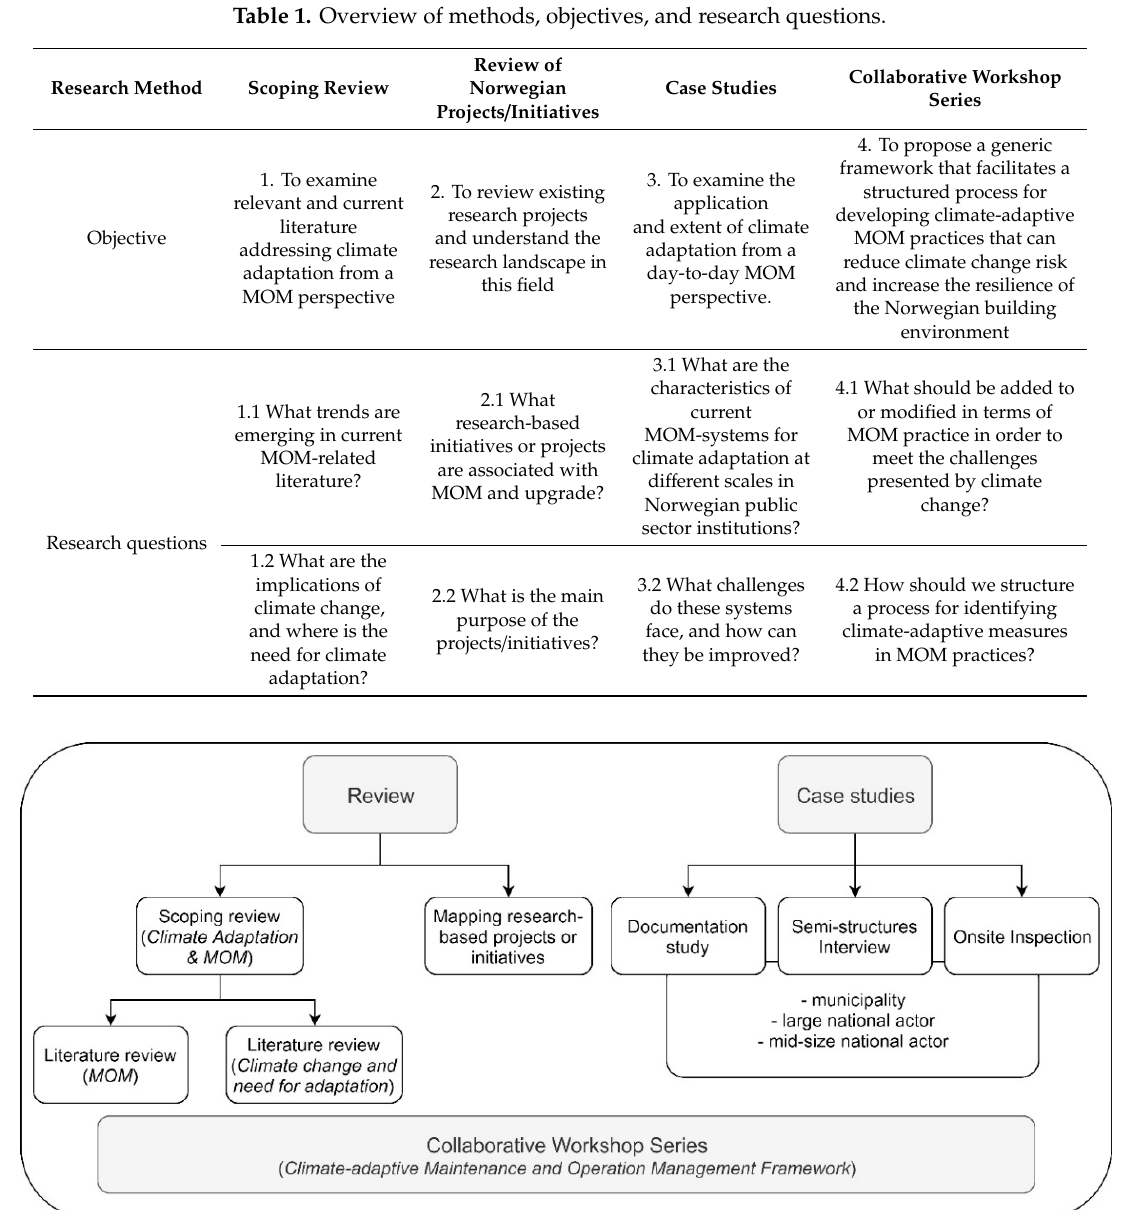
Figure 1. General overview and structure of the methodology.